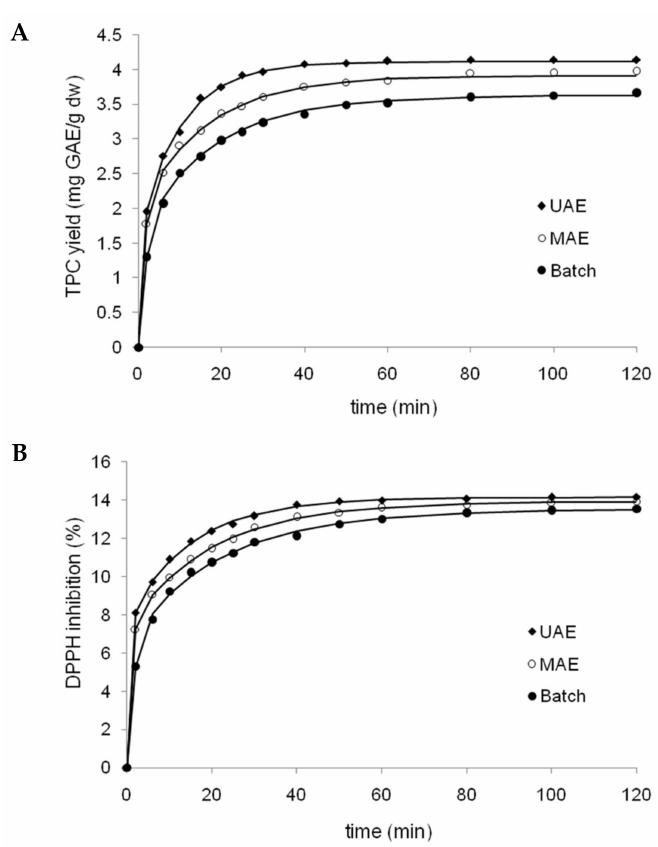
Figure 3. Kinetics profiles of polyphenols extraction ( A ) and antioxidant activity ( B ) of extracts obtained by three tested methods (batch system, ultrasound and microwave assistance) from brewer’s spent grain (BSG) fitted by patricelli’s model. Symbols: Experimental data; lines: Model fitting